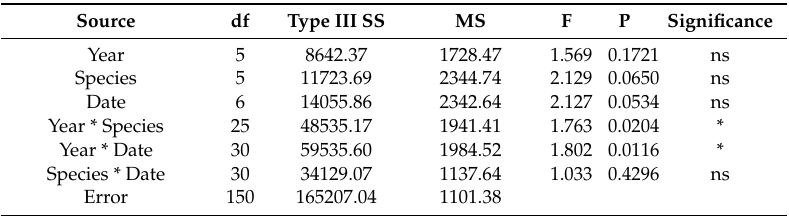
Table 1. Summary of the analysis of variance of insect pest population dynamics (e ff ect of factors or interaction between factors is significant if p value is lower than 0.05). Source